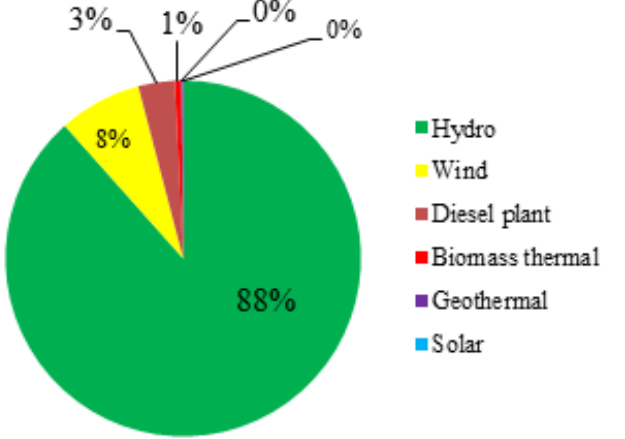
Figure 1. Ethiopia’s power generation mix (2018–2019) [4].